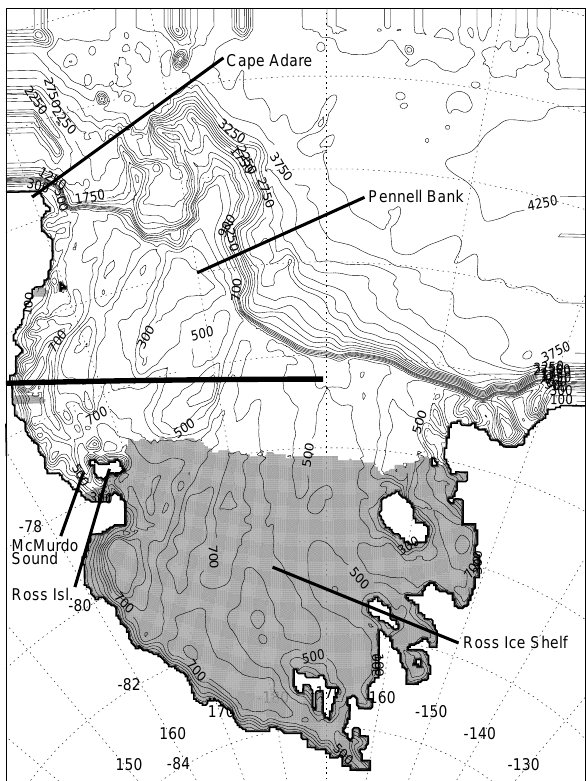
Fig. 1. Domain for Ross Sea model. The contour interval for the bathymetry is 100m up to 1000m depth and 250m beyond. The shaded area is the part of the model covered by the Ross Ice Shelf. The horizontal line is the cross section for Fig.